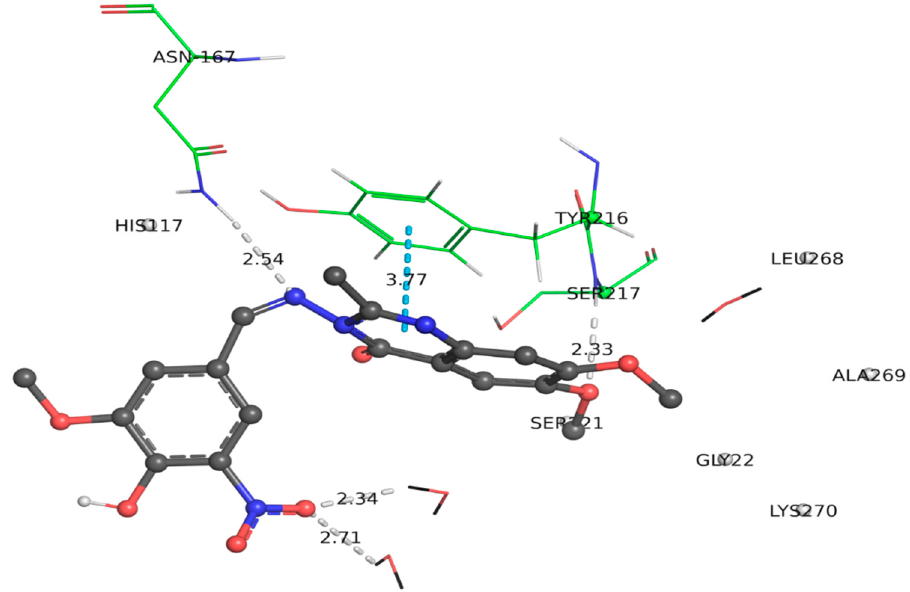
Figure 7. Docking pose of molecule ( 6a ) in the active site of 17 beta-HSD5 (pdb: